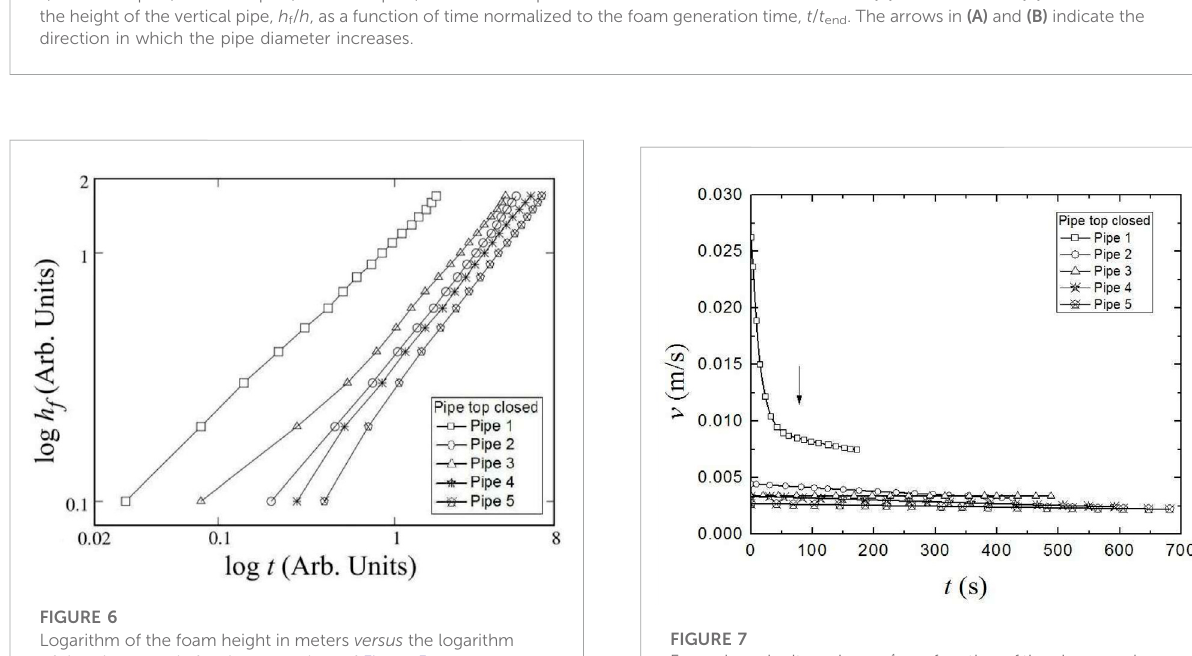
FIGURE 7 Foam risevelocity, v f ,inm s − 1 as afunctionoftimeinseconds for foam columns generated in closed-top pipes of varying diameters. The arrow indicates the direction in which the pipe diameter